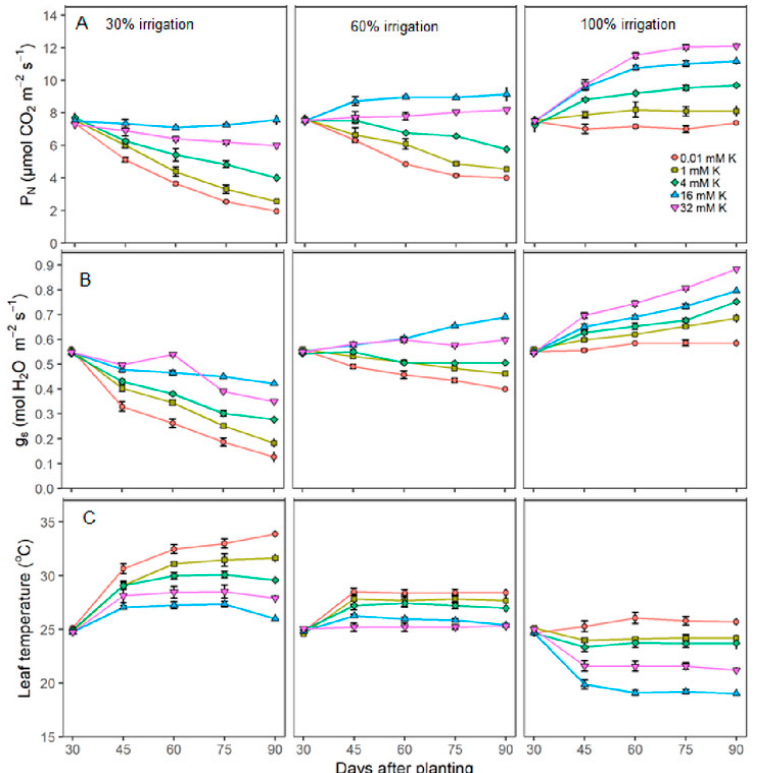
Figure 2. Net photosynthesis P N ( A ), stomatal conductance g s ( B ), and leaf temperature ( C ) of young cassava plants in response to deficit irrigation and K fertigation. The treatments were initiated 30 days after planting and lasted 60 days. The data from four separate experiments were combined and shown as the means ± standard error of 4 to 16 replicate plants.